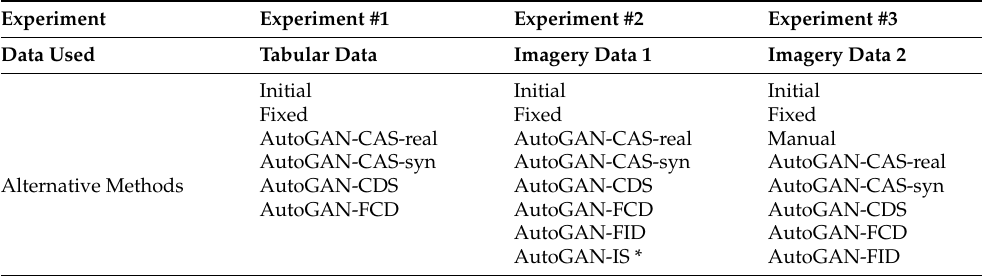
Table 2. Overall description of the three main experiences carried out. (* AutoGAN-IS was only used with imagery datasets that contain colored